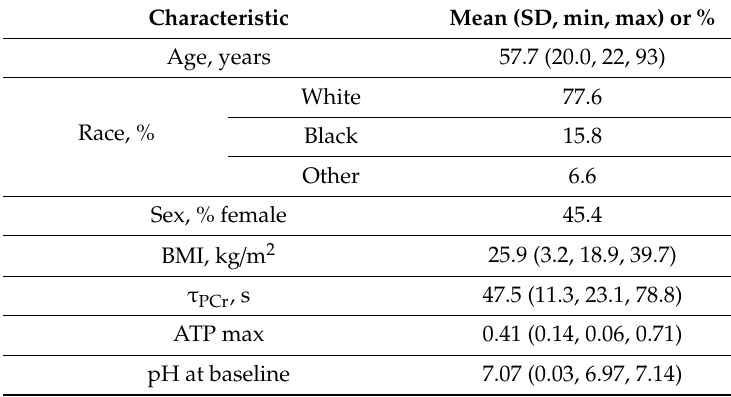
Table 1. Demographic and health characteristics of 165 study